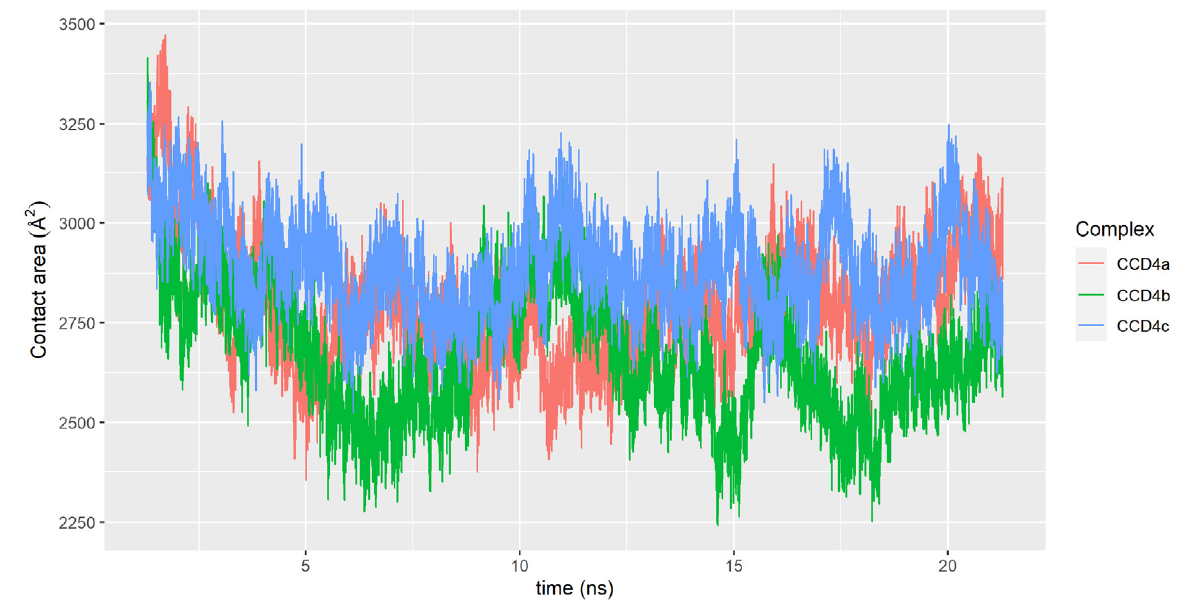
Figure 8. Evolution of the contact surface area (Å 2 ) in the complexes formed by CCD4a (red), CCD4b (green), and CCD4c (blue) and the membrane. CCD4a displays a mean value of 2797.15 ( ± 153.89) Å 2 , CCD4b of 2674.08 ( ± 163.75) Å 2 , and CCD4c of 2885.87 ( ± 118.13) Å 2 .